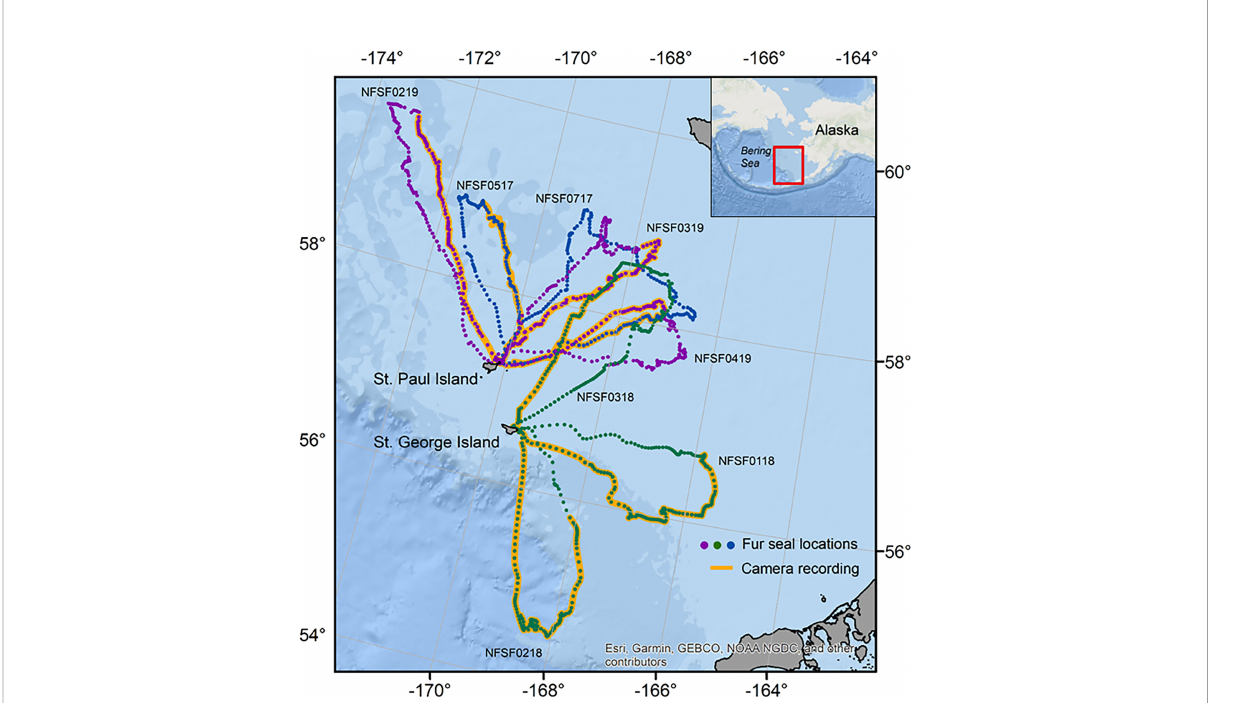
FIGURE 1 Hourly locations for eight northern fur seals (2017: blue, 2018: green, and 2019: purple points) equipped with animal-borne video cameras. The portion of the foraging trip with video data is highlighted in orange. Northern fur seals were instrumented on St. Paul Island and St. George Islands in the Bering Sea, Alaska